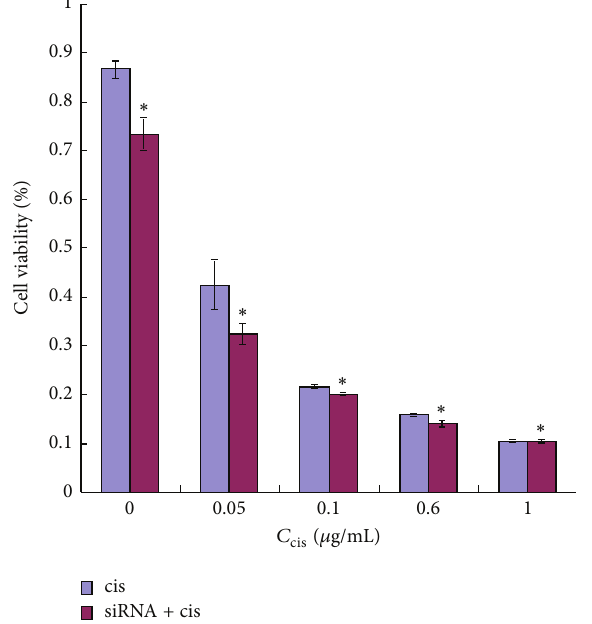
Figure 2: Effects of mTOR siRNA on cell proliferation and sensi- tivity to cisplatin. To determine the effects of mTOR siRNA on cell proliferation and sensitivity of ESCC cells with mTOR siRNA to cisplatin, proliferations of the cells with or without mTOR siRNA treated with cisplatin at different concentrations for 24 h were detected with WST-8 dye. Results pooled from three independent experiments were expressed as mean ± SD. ∗ 𝑃 < 0.05 , compared to untreated cells.